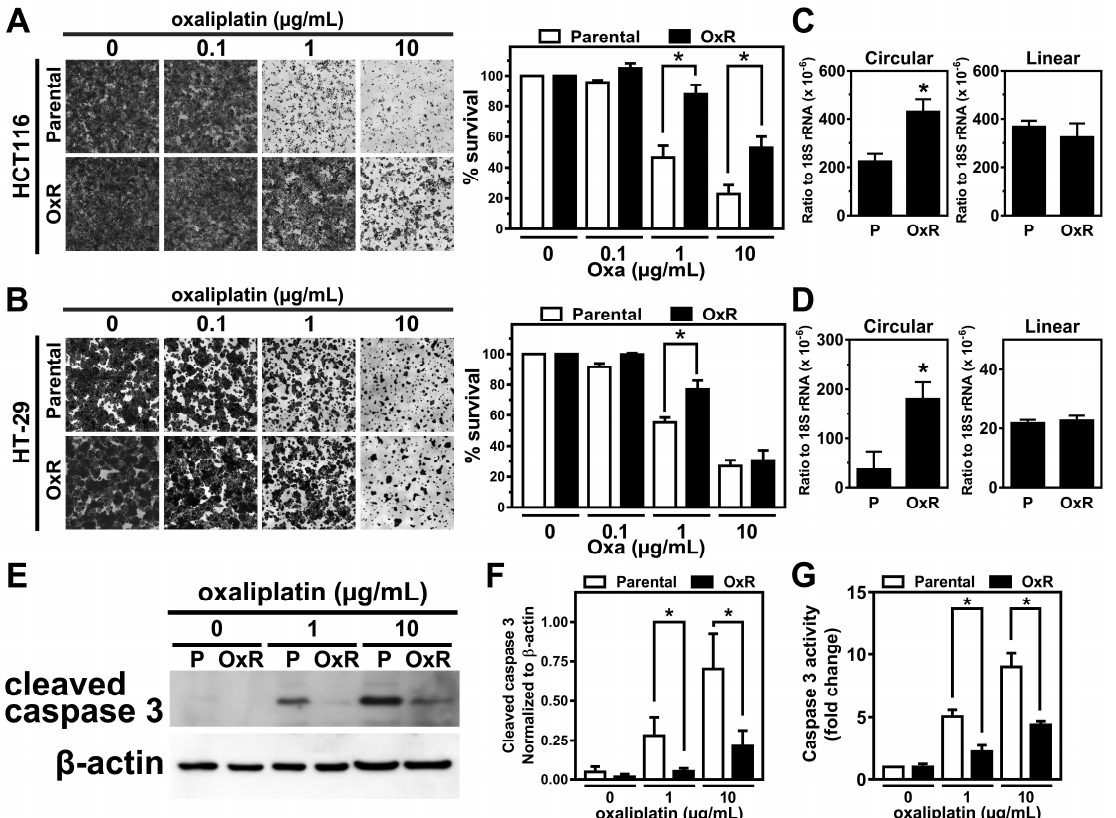
Figure 1. The level of circCCDC66 is elevated in the oxaliplatin-resistant cells. ( A ) The results of Coomassie blue staining from HCT116 cells without (parental cells) or with oxaliplatin resistance (OxR) treated with the indicated concentrations of oxaliplatin for 48 h. The right panel shows the quantitative results. ( B ) Similar to (A), performed in HT-29. ( C,D ) The levels of circular transcript and mRNA (linear transcript) of CCDC66 assayed by using RT-qPCR in HCT116 and HT-29 cells without / with oxaliplatin resistance. ( E ) The representative images for cleaved caspase 3 and β -actin from parental and oxaliplatin-resistant cells treated with the indicated concentrations of oxaliplatin for 48 h. ( F ) Quantitative results for (E). ( G ) Caspase 3 activities from cells with indicated treatments. * p < 0.05.